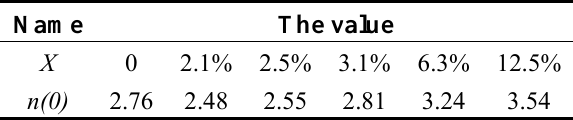
Bi with different Bi content. 1-x x